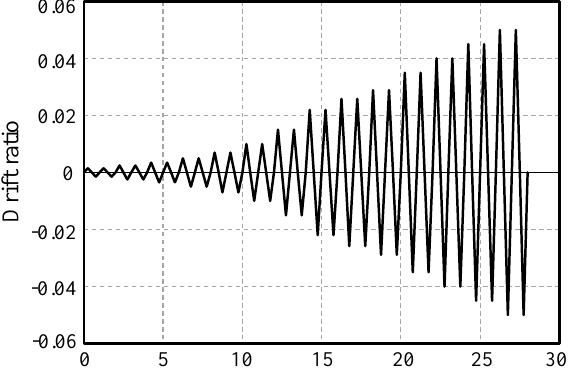
Number of loading cycle Figure 10. Loading protocol for the quasi-static loading Figure 10. Loading protocol for the quasi-static loading test. Figure 10. Loading protocol for the quasi-static loading test.